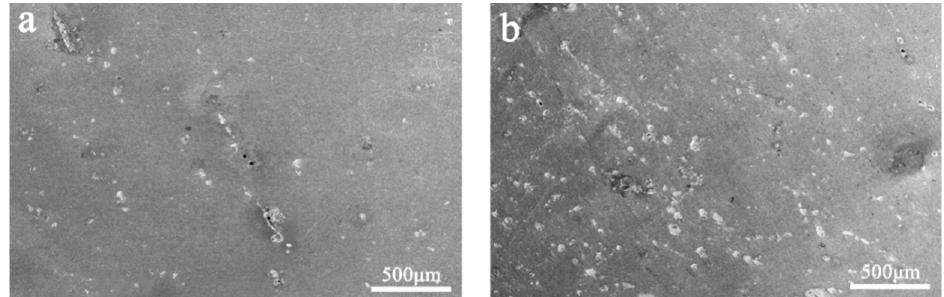
Figure 13. Corrosion surfaces of the alloy tested in 3.5% NaCl solution: ( a ) peak-age alloy and ( b ) over-age alloy.